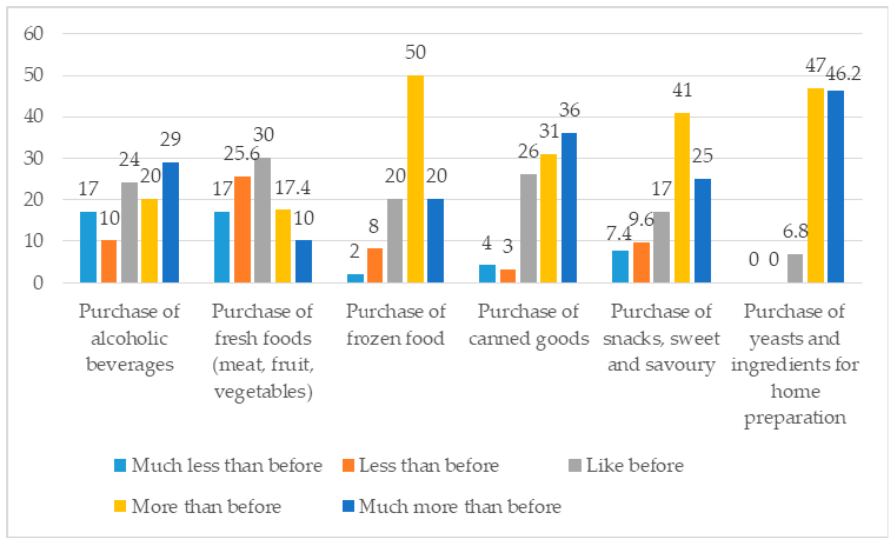
Figure 2. Changes in food purchase (%). Source: own processing of pilot survey. In relation to the choice of distribution channels, after an initial, almost exclusive orientation towards large-scale distribution, there was a subsequent passage to neighbourhood shops (including fruit and butcher shops), both because of the introduction of restrictions on movement and because they often had shorter queues. These shops were also sometimes considered safer than larger, busier environments. Hypermarkets were particularly penalized in the months of lockdown because they were located within shopping centres in which all other stores had been closed, further discouraging consumers from going there (Figure 3).